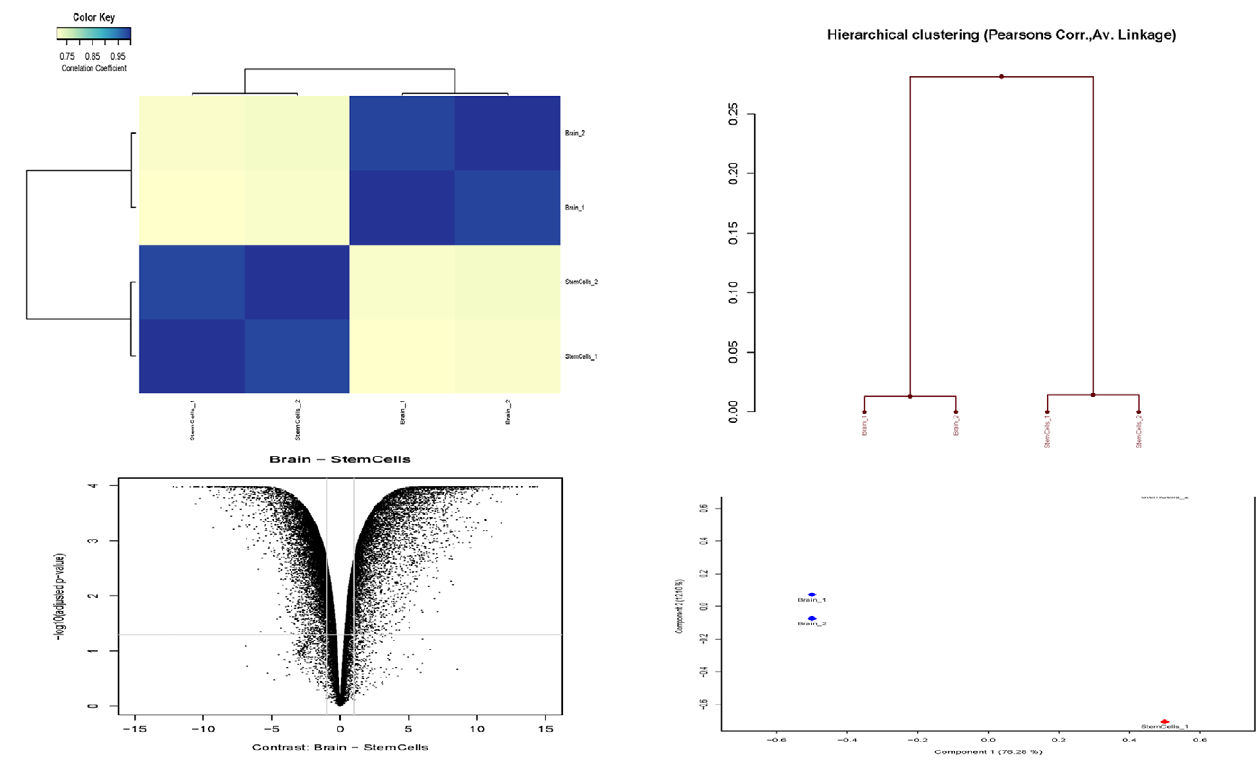
Figure 2. The correlation between human embryonic neural stem cells (StemCells_1,2) and dopaminergic cells (Brain_1,2), and also among the two arrays of the same sample. There was no correlation (yellow colors) between hENSC and DA cells samples. But there was a strong correlation (blue colors) between the arrays from the same samples (A). Hierarchical clustering analysis using GeneSpring GX Software. Hierarchical clustering dendrogram of relative gene expression in different populations was generated using the GeneSpring GX Software (B). hENSCs (stem_1, and stem_2) clustered together and are distinguished from human substantia nigra dopaminergic cells (Brain_1, and Brain_2). Unsupervised hierarchical clustering based on overall gene expression profiles reveals two distinct clusters corresponding to the two cell groups. This suggests that the samples from the two cell types (hENSC vs DA cells) do indeed represent two statistically distinct populations suitable for valid comparison. Scatter-plot used to quickly identify discrepancies in gene expression profiles between hENSC and DA cells from human substantia nigra (C). Both cell populations could be clearly discriminated based of differences in their gene expression profiling. Principal component analysis (PCA) which is useful when we expect samples to be linearly (or even monotonically) related to each other (D). As you see here samples from the hENSC and from human subastantia nigra DA cells are completely different.